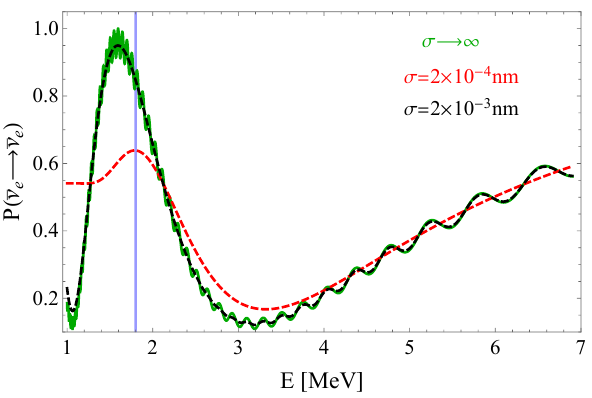
Figure 1 . The electron antineutrino oscillation probability as a function of the neutrino energy for the JUNO average baseline of L = 52 : 5 km for di(cid:11)erent values of the decoherence parameter (cid:27) . The values of the standard oscillation parameters are listed in eq. (2.5). The blue, vertical line indicates the threshold for inverse